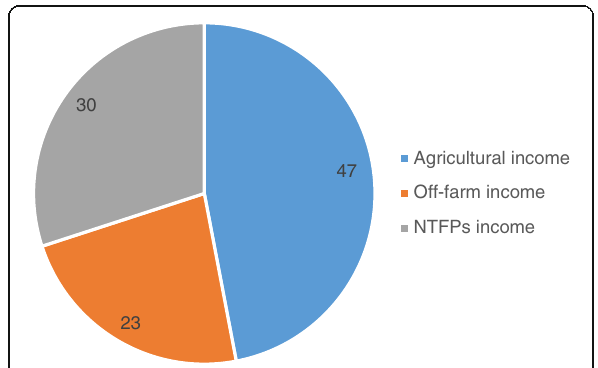
Fig. 4 Percentage contribution of agriculture, off-farm, and non- timber forest products incomes to the total household